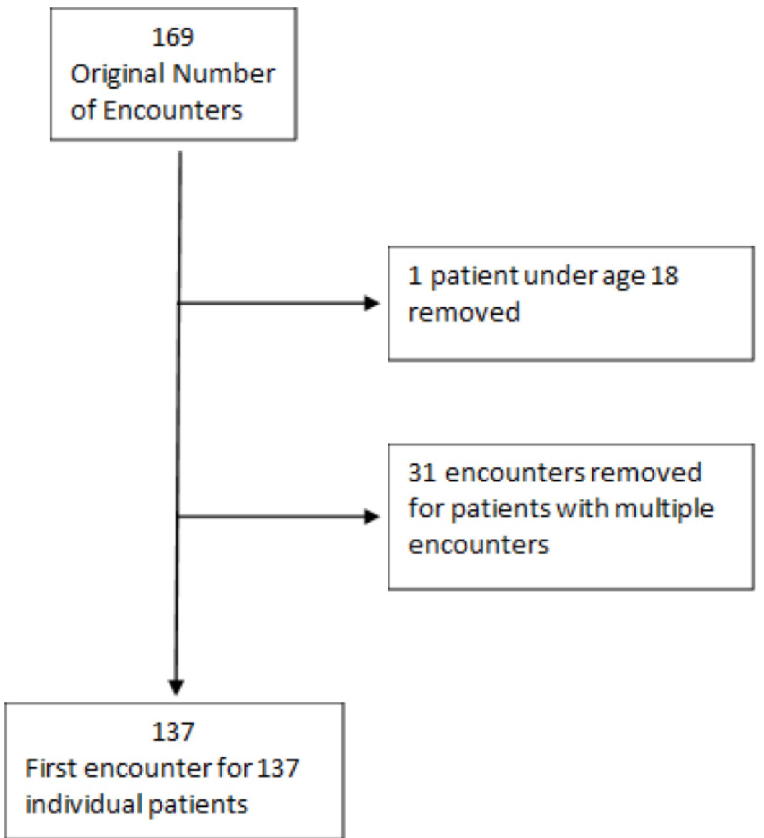
Fig 1. CONSORT diagram of patients diagnosed with a spinal epidural